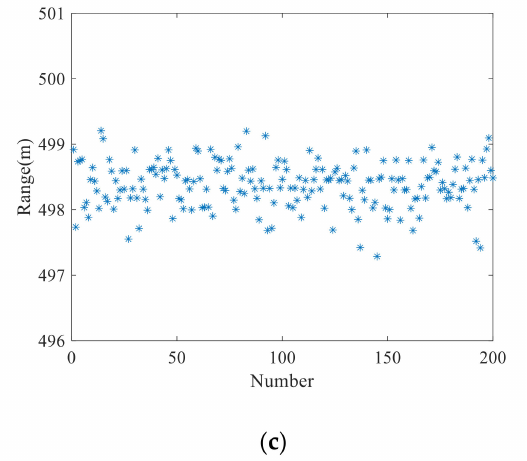
Figure 8. ( a ) Range measurement results over 200-time tests of the proposed method ( a ), the Doppler frequency shift method ( b ), and the three-point method ( c